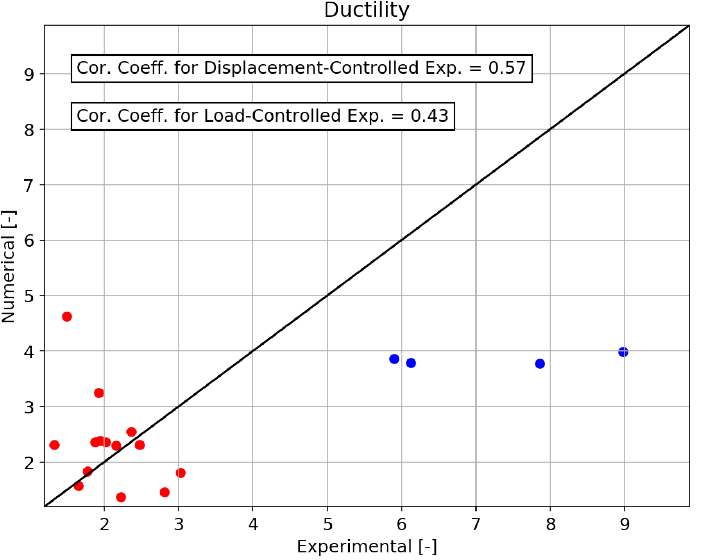
Figure 11. Comparison between numerical and experimental results regarding the beam’s ductility factor. Red dots mark load-controlled experiments. Blue dots mark displacement- controlled